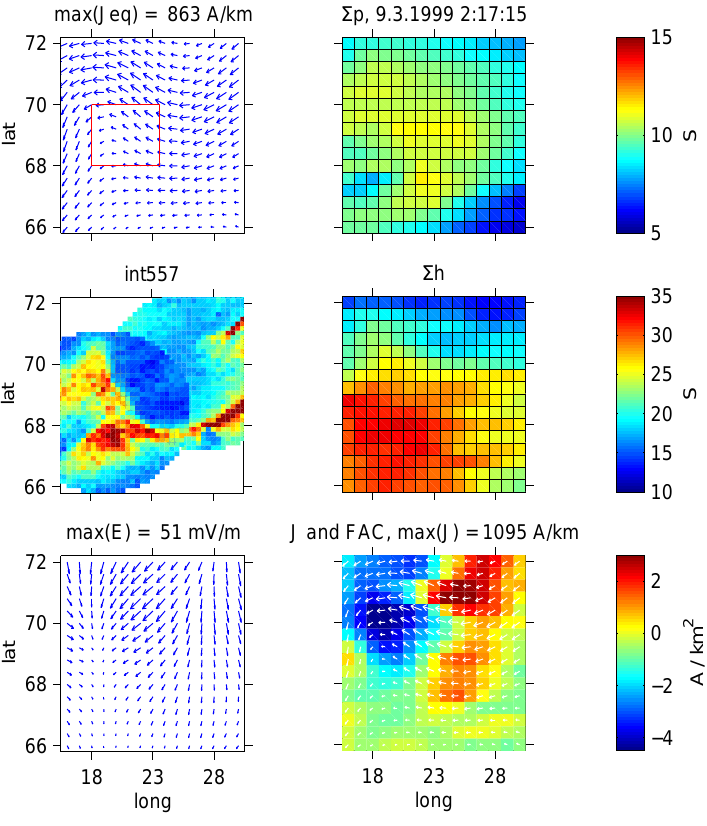
Fig. 6. Snapshot of ionospheric electrodynamic variables at 02:17:15UT. Input data used in the local KRM method: Equivalent current Jeq, Pedersen and Hall conductances. Output of the KRM method: Ionospheric electric field E, horizontal current J and field-aligned current FAC. Positive FAC is downwards. Additionally, also the auroral intensity at 557nm is shown in the middle left panel (cameras at ABK and KEV stations in Fig. 1, intensity is uncalibrated so no scale is shown). Here we use the UVI conductance estimate. The smaller area where the emap conductance estimate is available is indicated by the red rectangle in the top left